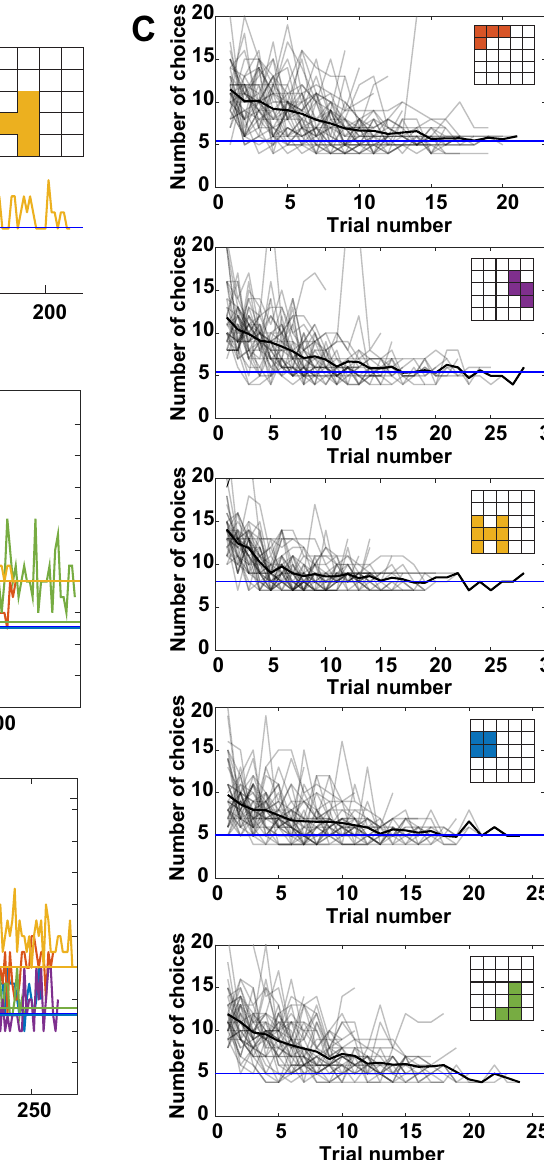
Figure 2. ( A ) Sample learning curve for the ‘H’ shape for M1. Early in learning, M1 required a larger number of choices to finish revealing the shape than later in learning; by the end of learning, M1 was at or near optimal (thick blue line) for the shape. ( B ) Learning curves for M1 (top) and M2 (bottom) for all shapes. Each color is a distinct shape and maps on to the shape colors in Fig. 1A. ( C ) Learning curves for all humans (n = 42; light gray lines: individual participants; thick black line: average) for all shapes. All plots: thick horizontal lines: optimal number of choices for that